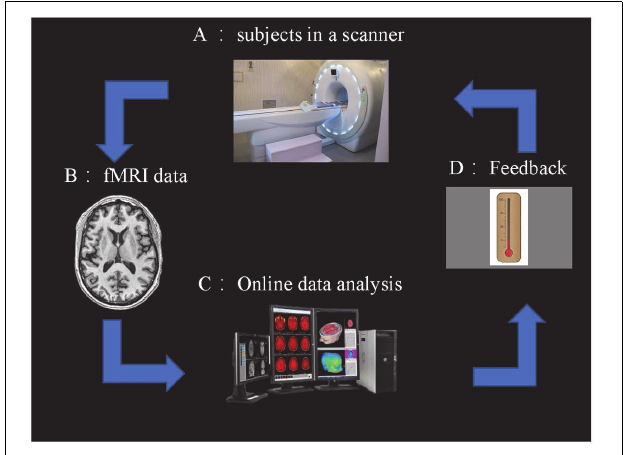
FIGURE 2 | Overview of an rt-fMRI NF system. (A) Subjects in the fMRI scanner. (B) fMRI data acquisition using an echo planar imaging (EPI) pulse sequence. (C) Online data analysis and computation of the NF based on the BOLD responses. (D) NF via a scanner projection